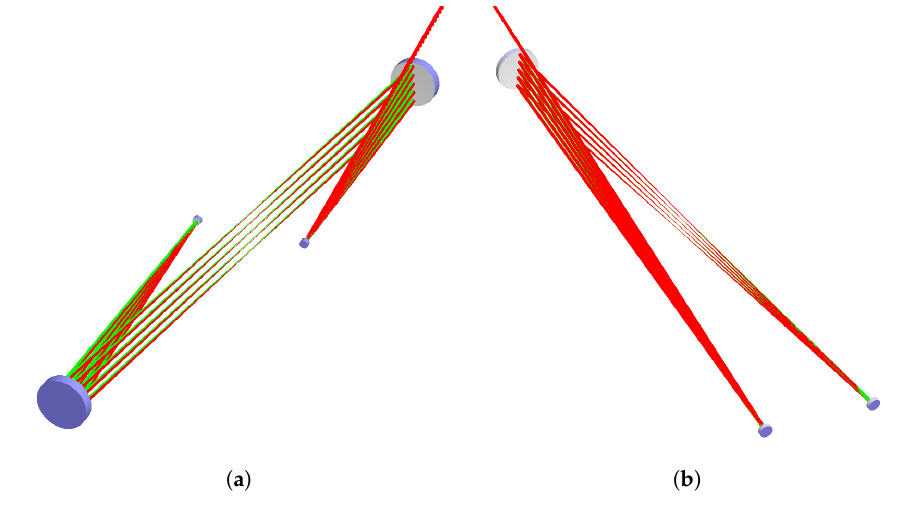
Figure 4. Three dimensional setup of the basic layouts for Type I ( a ) and Type II ( b ) systems in FRED. Both layouts have a half folding angle of θ = 5 ◦ and five passes.